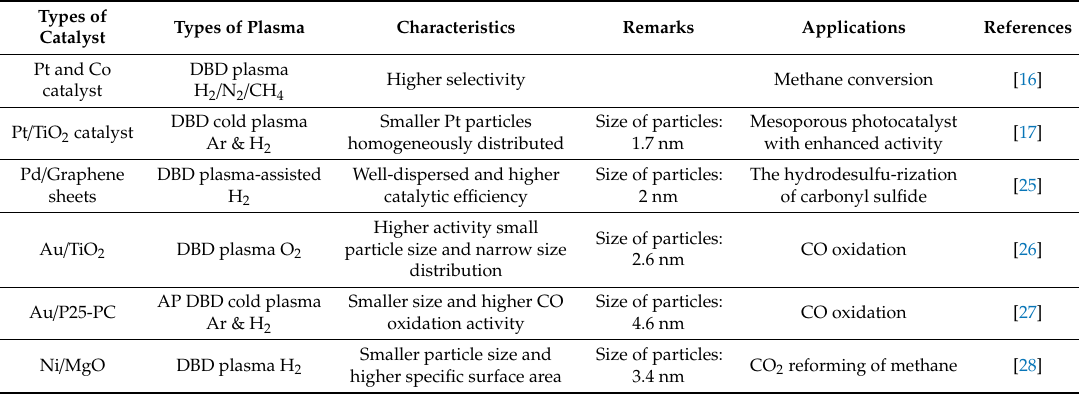
Table 1. Highly dispersed catalysts prepared by a plasma